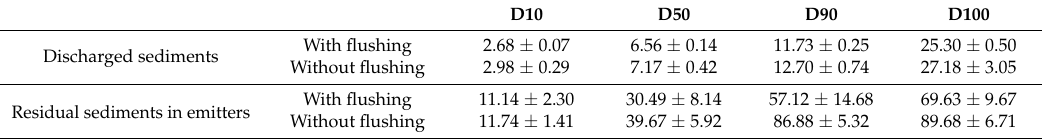
Table 6. Average particle size of residual sediments in emitters and discharged sediments ( µ